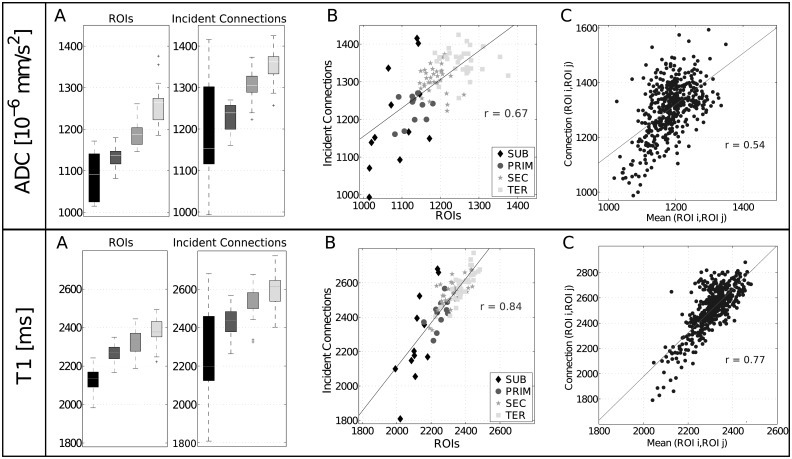
ROIs and incident connections.A: Distribution of ADC [10−6 mm/s2] (top) and T1 [ms] (bottom) values for each ROI group and the incident connections. B: Scatterplot for ADC (top) and T1 (bottom) in ROIs and their incident connections, for all ROIs. Pearson’s correlation: ADC r = 0.67, p < 10−10; T1 r = 0.84, p < 10−10. Groups: SUB (n = 12) in black (diamonds), PRIM (n = 12) in dark gray (circles), SEC (n = 34) in gray (stars), TER (n = 32) in light gray (squares). C: Correlation between mean ADC [10−6 mm/s2] (top) and T1 [ms] (bottom) of GM ROI pairs and average ADC value along the connecting WM tracts (ADC: Pearson r = 0.54, p < 10−10, T1: Pearson r = 0.77, p < 10−10; n = 450).